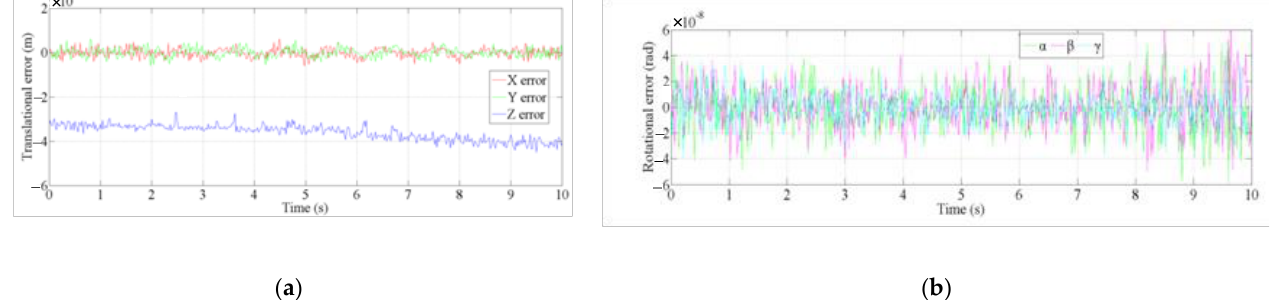
Figure 11. Path tracking errors: ( a ) Position error; ( b ) Directional attitude angle error.